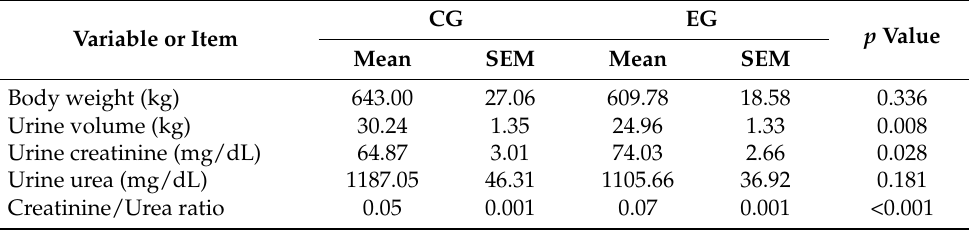
Table 4. Body weight, urinary volume and constituents of dairy cows grouped by low (CG) or high (EG) locomotion